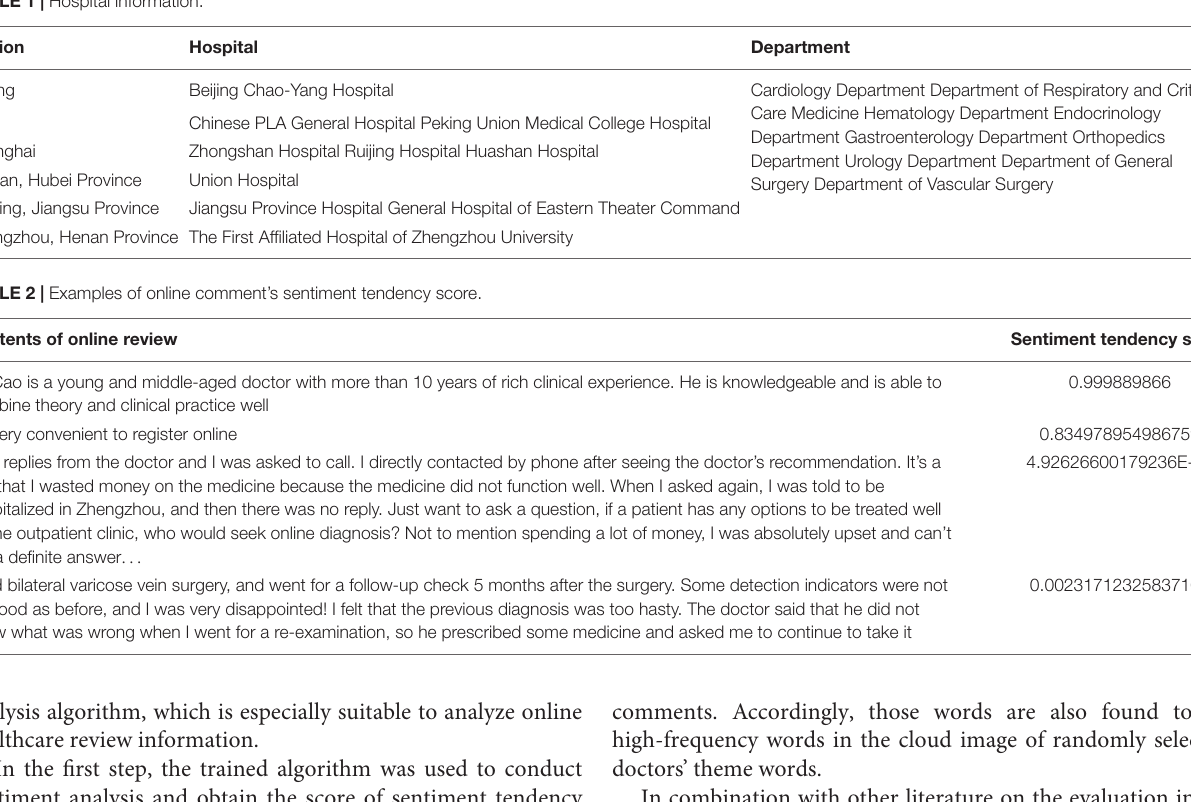
TABLE 1 | Hospital information.